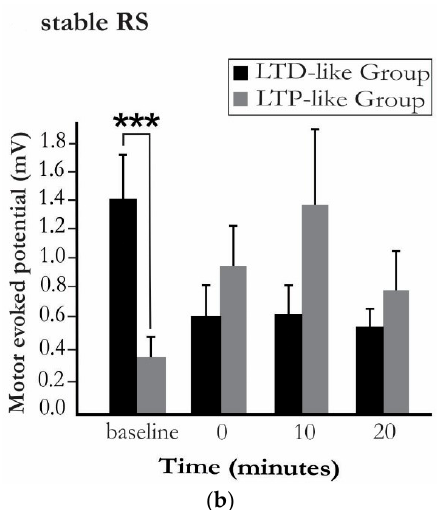
Figure A1. ( a ) Normalized MEP amplitude (mean ± standard error) at dynamic level of RS and ( b ) MEP amplitude (mean ± standard error) at stable level of RS, across the subjects from the LTP/LTD-like groups within the trials before (baseline) and at 0, 10, and 20 min after the induction of short-term plasticity with PAS. Subjects in the LTD-like group exhibited significantly higher pre-intervention MEP amplitudes (baseline) in dynamic RS ( p = 0.005), and stable RS ( p = 0.007). No significant difference was observed between the two clusters following PAS in either component. *** indicates significant differences for pairwise comparisons ( p < 0.01).